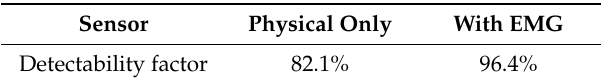
Figure 13. Experimental data for the continuous ascending stair: ( a ) motor encoder, ( b ) LBKA, ( c ) EMG raw data, ( d ) EMG filtered data, ( e ) NN probability, and ( f ) current state. Table 1. Detectability factor of each NN.